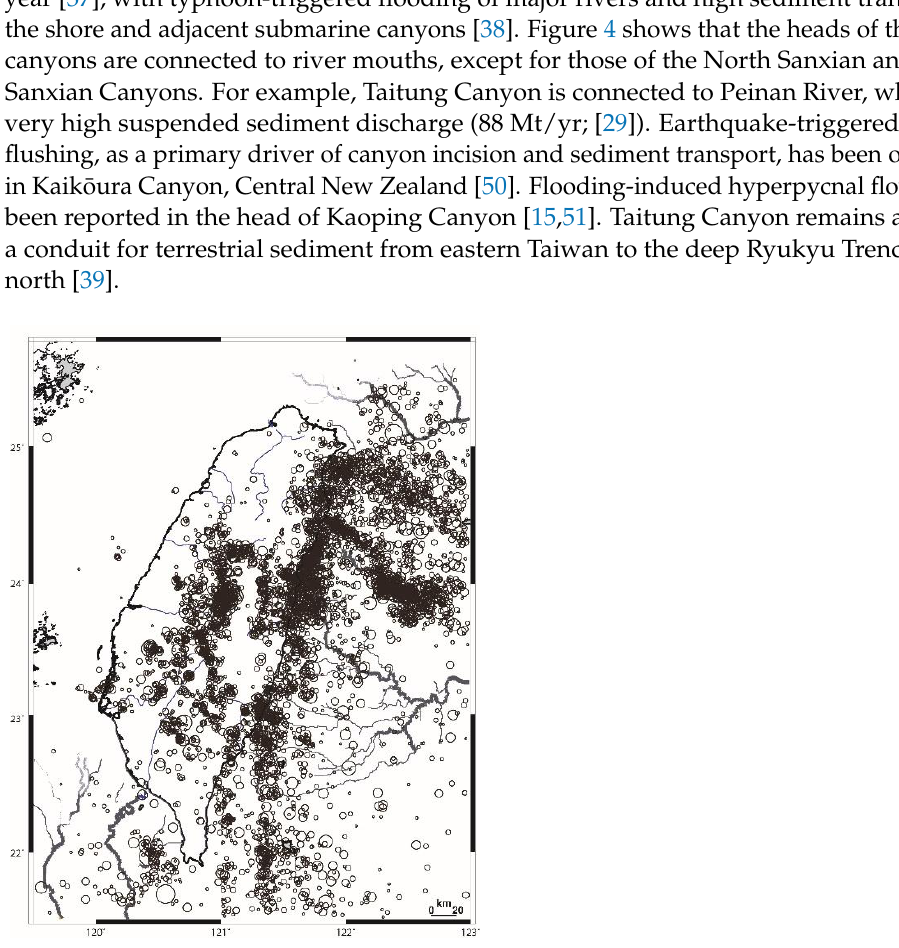
Figure 5. Distribution of earthquakes in the Taiwan area (Data from Central Weather Bureau, Taiwan, 2012). Note that the eastern Taiwan margin is characterized by frequent earthquake events.